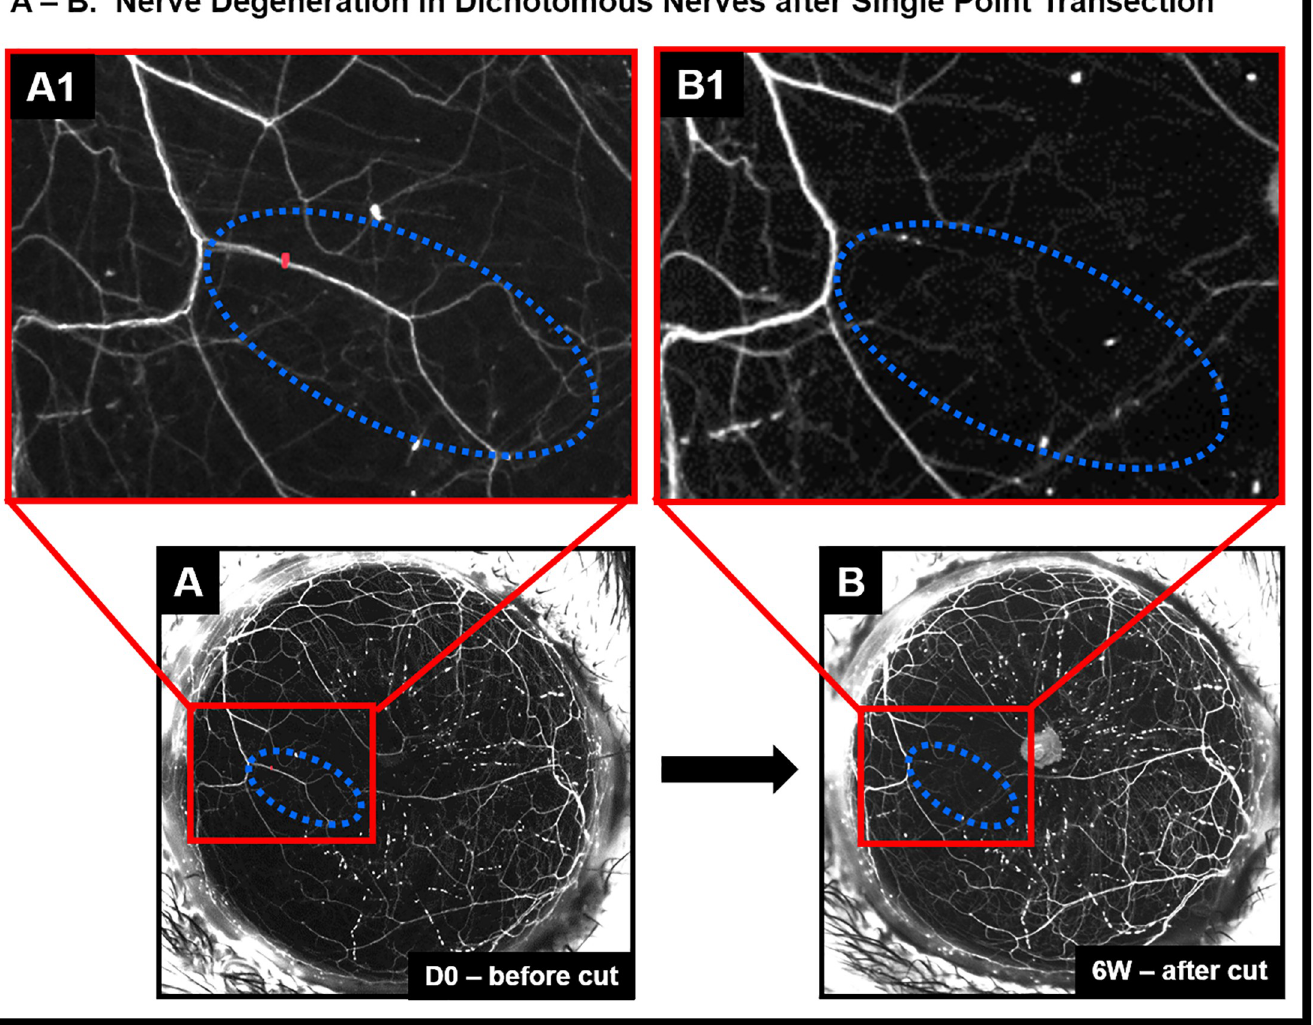
Fig 6. Nerve healing in dichotomous nerves after single point transection. Dichotomous nerves before transection (A) and six weeks after transection (B). Red mark indicates point of transection; blue dotted lines mark the zone around the transected dichotomous nerve. Insets show magnified view of the dichotomous nerve before transection (A1) and disappearance of the nerve fluorescence six weeks after transection (B1)., Panels A and B; Panels A1 and B1 are magnified insets of A and B respectively.